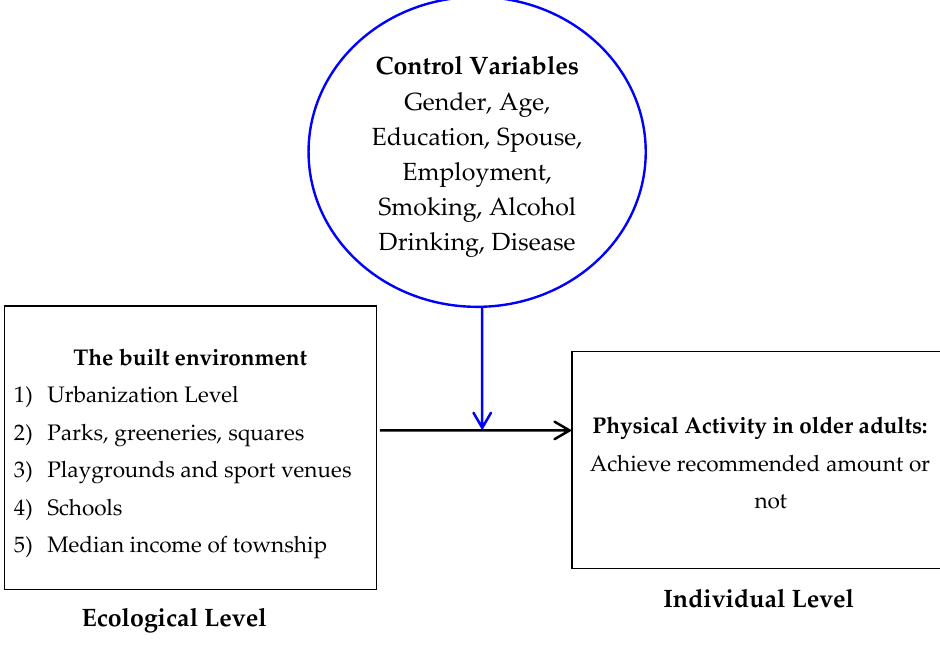
Figure 1. Study framework.